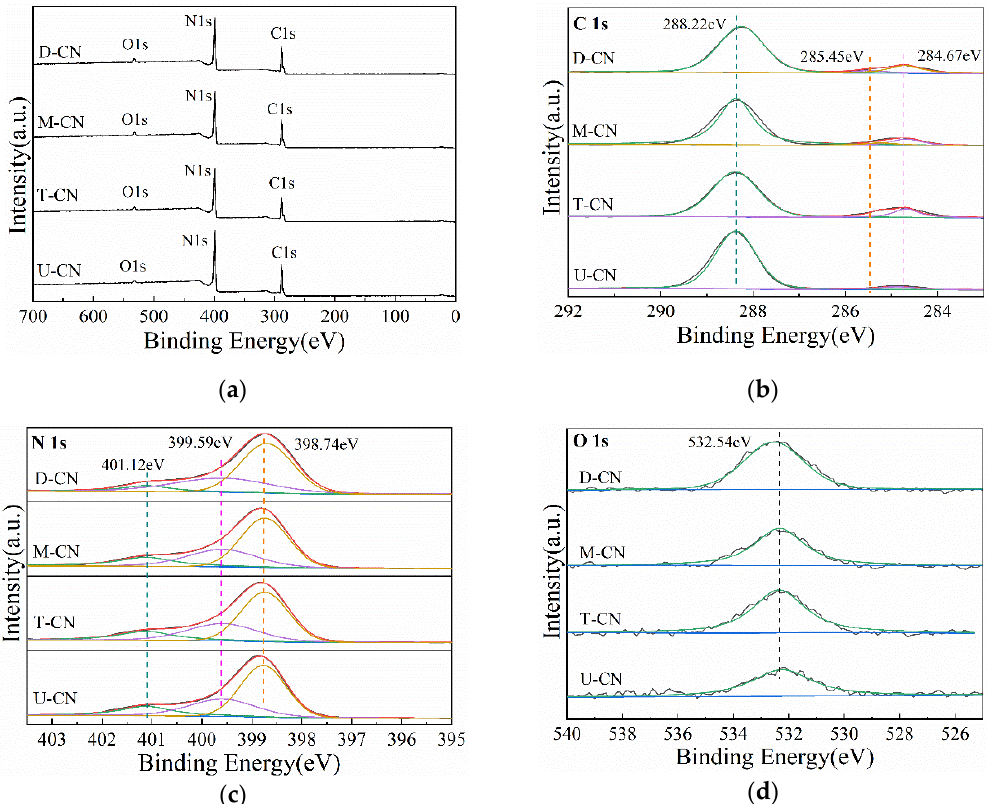
Figure 4. XPS spectra of the samples: ( a ) survey, ( b ) C1s, ( c ) N1s, and ( d ) O1s.